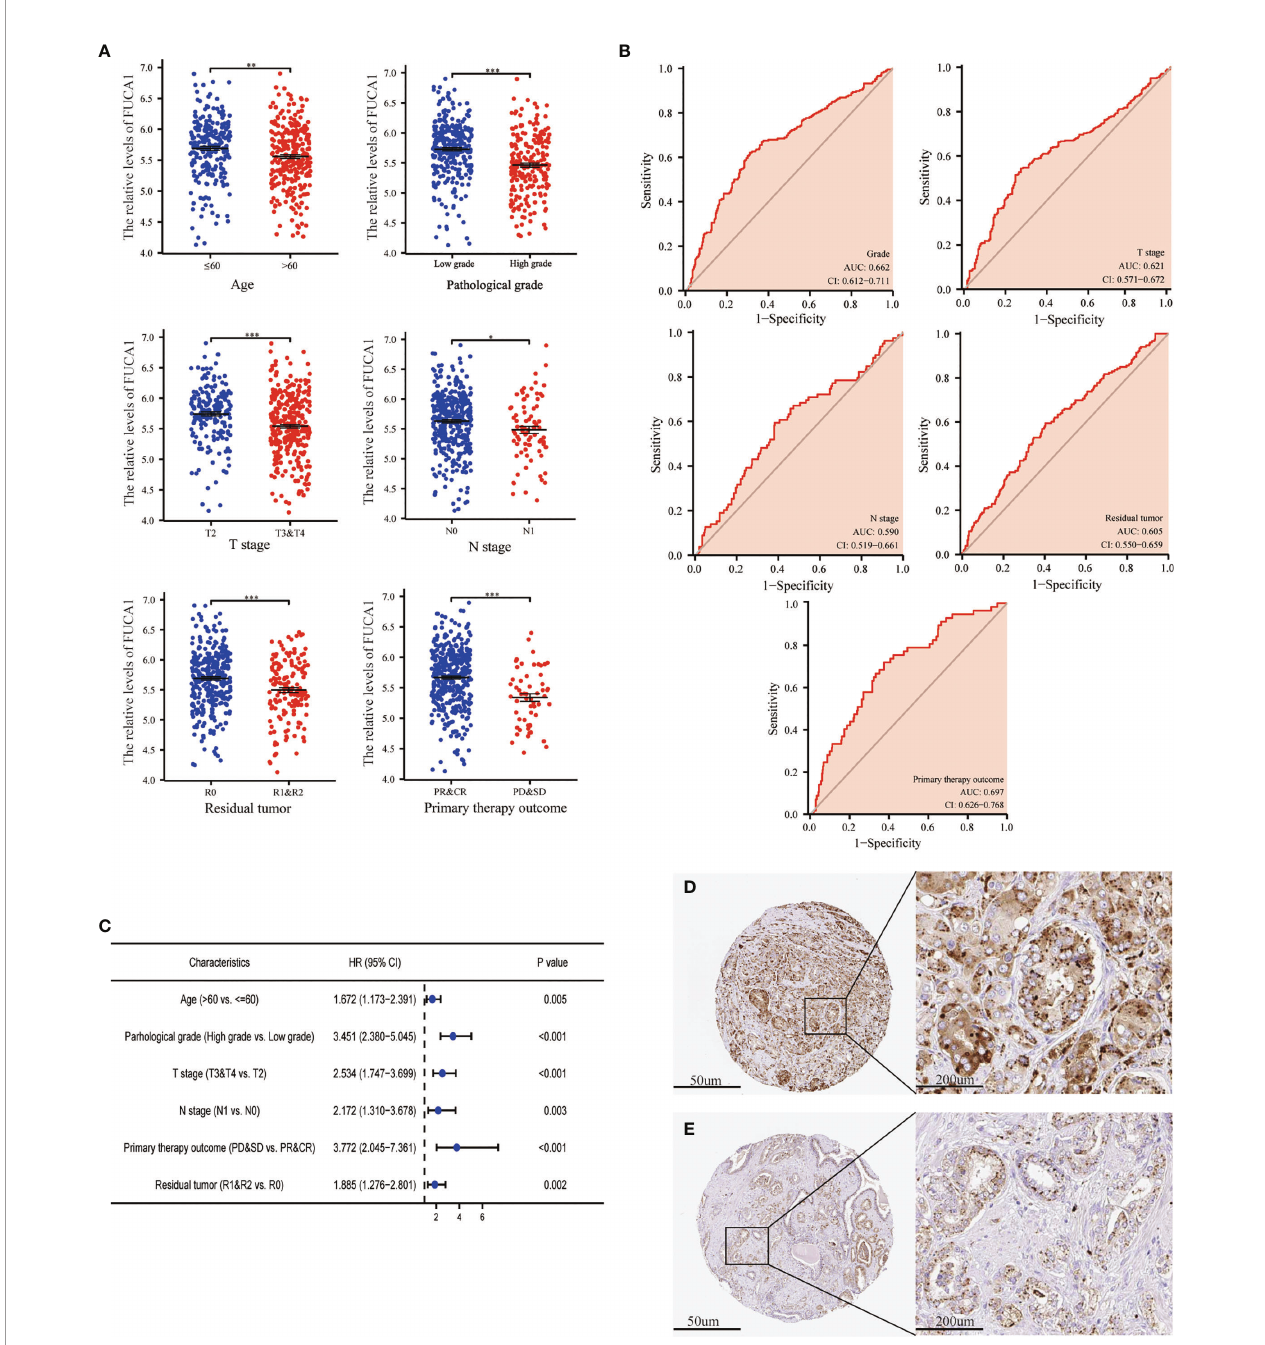
FIGURE 3 | The expression of FUCA1 in PCa subgroups. (A) FUCA1 mRNA expression in different PCa subgroups. (B) The diagnostic value of FUCA1 for different PCa clinicopathological parameters. (C) Logical regression analysis of clinicopathological variables ’ effects on low FUCA1 expression. IHC analysis of FUCA1 in low- (D) and high-grade (E) PCa tissue. CR, complete response; PR, partial response; SD, stable disease; PD, progressive disease. * p < 0.05, ** p < 0.01, *** p < 0.01. PCa, prostate cancer; IHC,